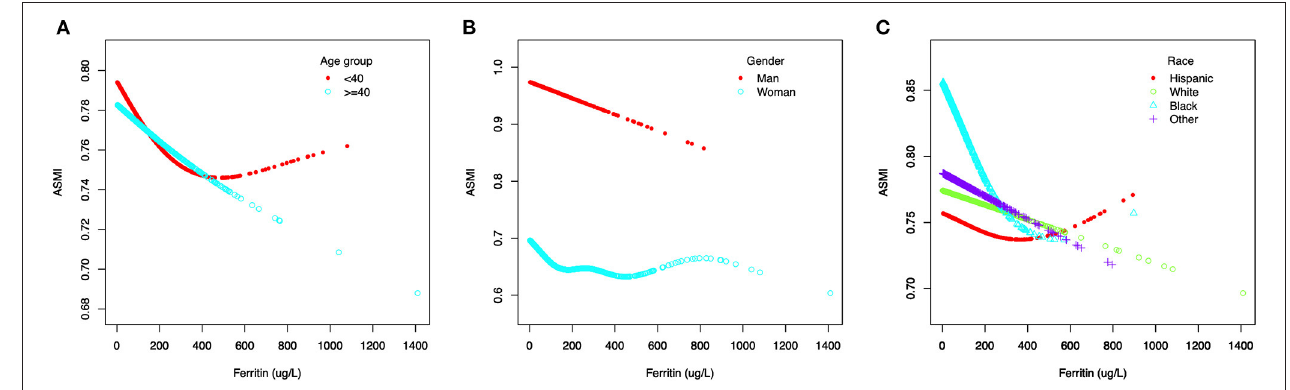
FIGURE 3 | The association between serum ferritin and muscle mass, stratified by age (A) , stratified by gender (B) , stratified by race (C) .